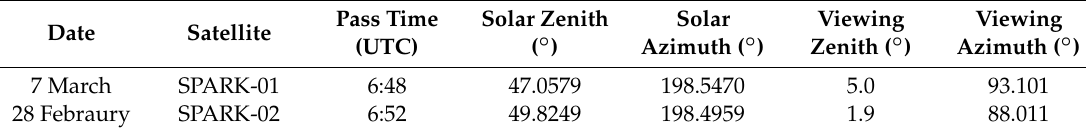
Table 3. SPARK image acquisition information for the relative calibration.